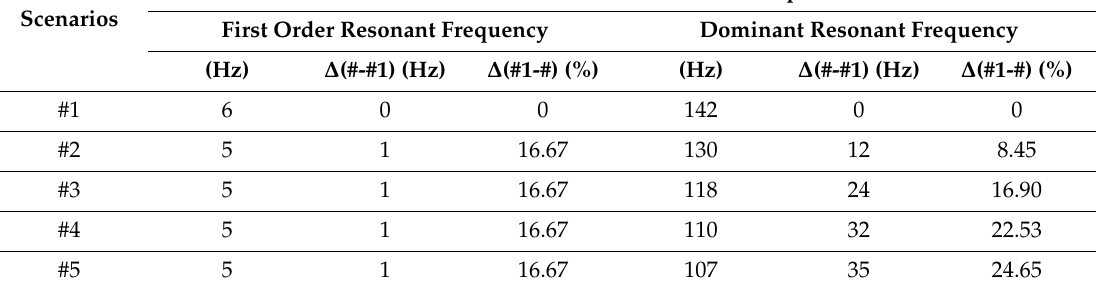
Table 4. The first order and dominant resonant frequencies comparison for five scenarios in the dynamic flexibility amplitude of the rail.